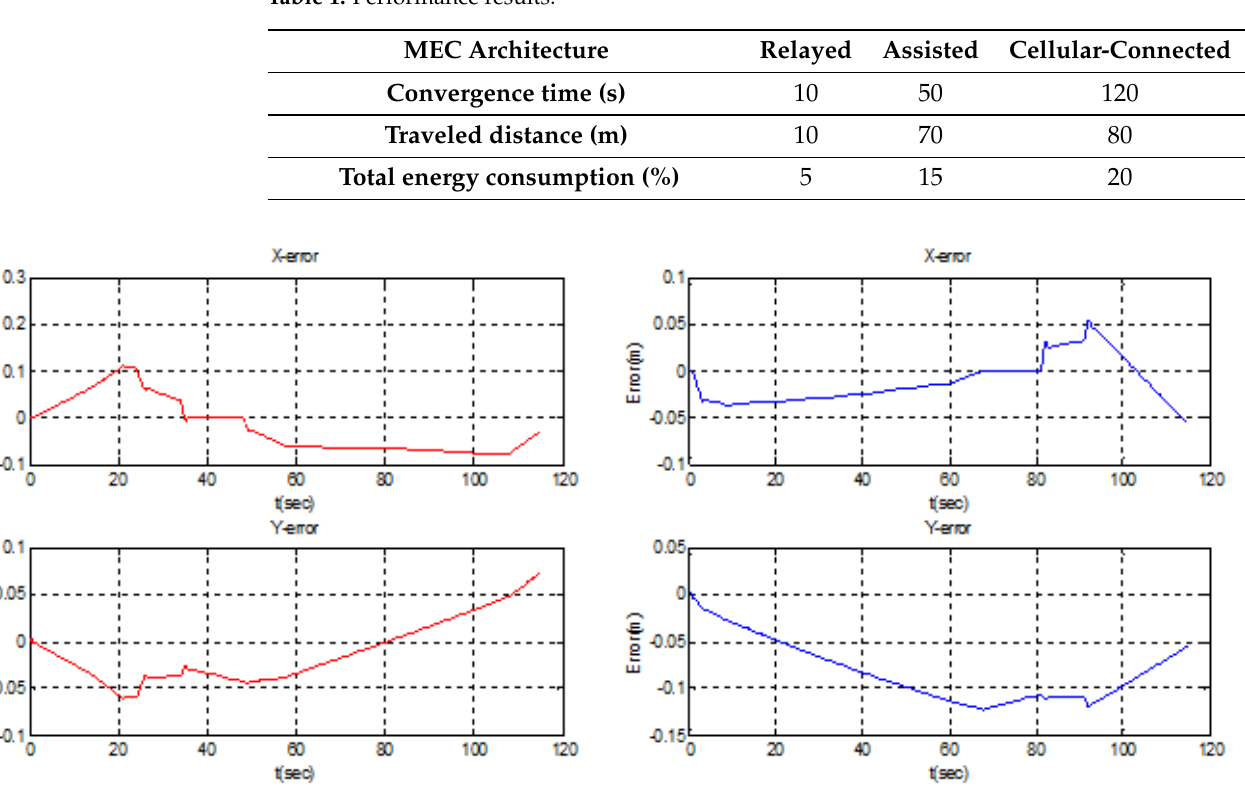
Figure 14. Obstacles avoidance tracking